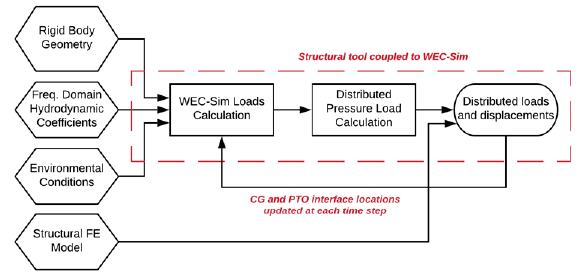
Fig. 6. Schematic of the coupled approach, where the structural tool and WEC-Sim are run at each time step.